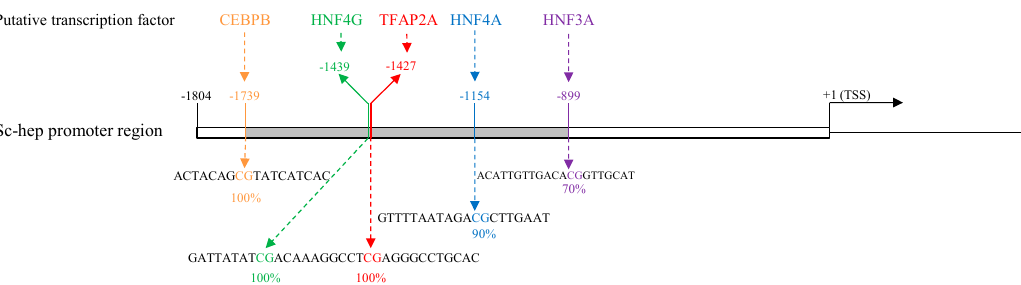
Figure 6. DNA methylation analysis of Sc-hep . TSS: transcription start site. The black box indicates Sc-hep promoter region. The percentages indicate the methylation level of five CpG sites. The dotted lines denote the CpG sites within the consensus sequence of putative transcription